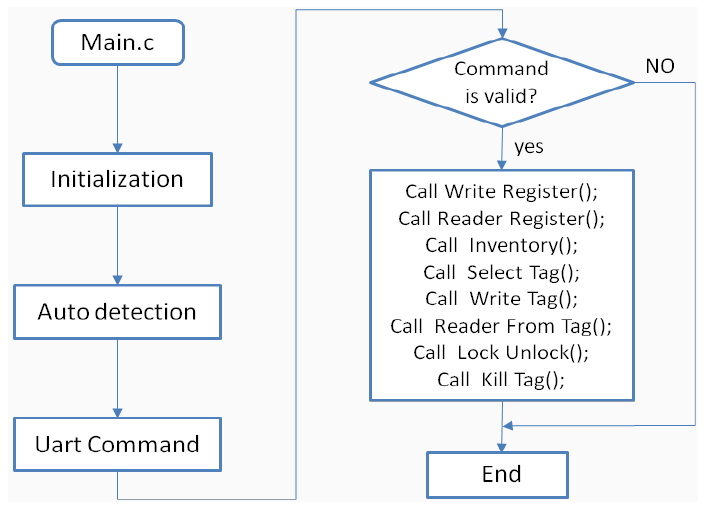
Figure 4. Reader software program